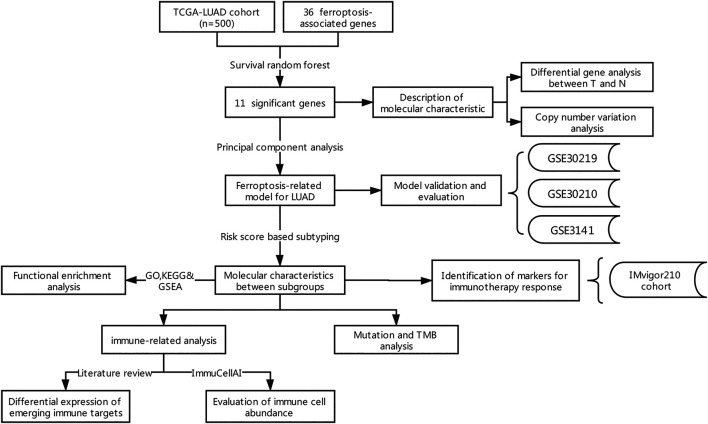
Flowchart of the comprehensive analysis of ferroptotic regulators in LUAD.